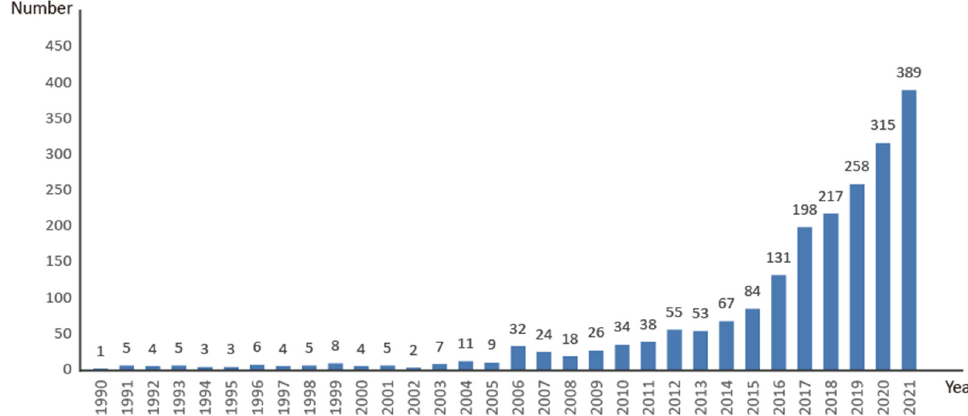
Figure 1. Number of published articles on urban microclimate.